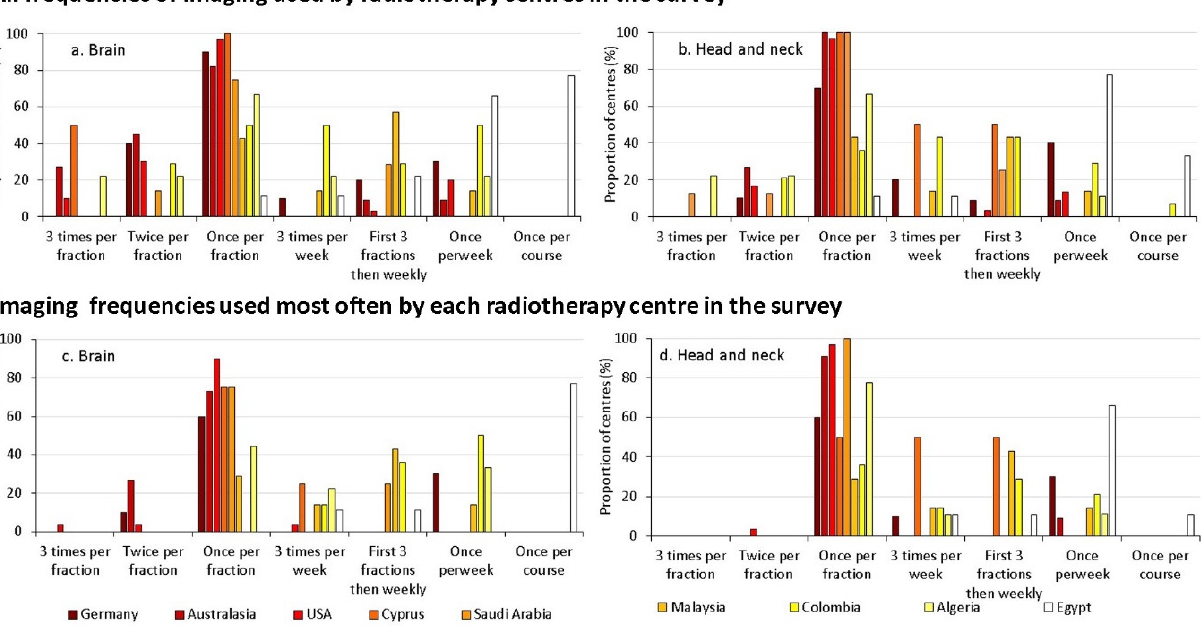
Figure 3. The frequencies of imaging used more commonly by each radiotherapy centre during treatment of the brain ( a , c ) and head and neck tumours ( b , d ), as a proportion of the centres surveyed in the country; ( a , b ) representing all the frequency options used, and ( c , d ) the ones used most frequently [14]. The countries are ordered using a temperature scale from white to dark red indicating increasing HDI.